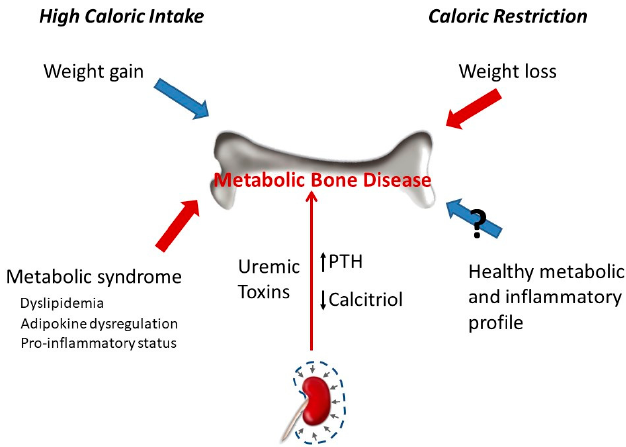
Figure 4. Chronic kidney disease leads to metabolic bone disease due to direct action of uremic toxins on bone and to associated changes in mineral metabolism (e.g., decreased calcitriol, increased parathyroid hormone (PTH)). The effect of calorie intake on bone can be differentiated in two types of mechanisms: mechanical stress associated with body weight and metabolic/inflammatory changes. The gain in body weight secondary to high calorie intake promotes bone anabolism due to increased mechanical load, and the opposite happens when body weight is lost after calorie restriction. However, the metabolic and inflammatory changes associated with high calorie intake are deleterious for bone, while the healthier metabolic and inflammatory profile observed after calorie restriction may (?) help to preserve bone mass.